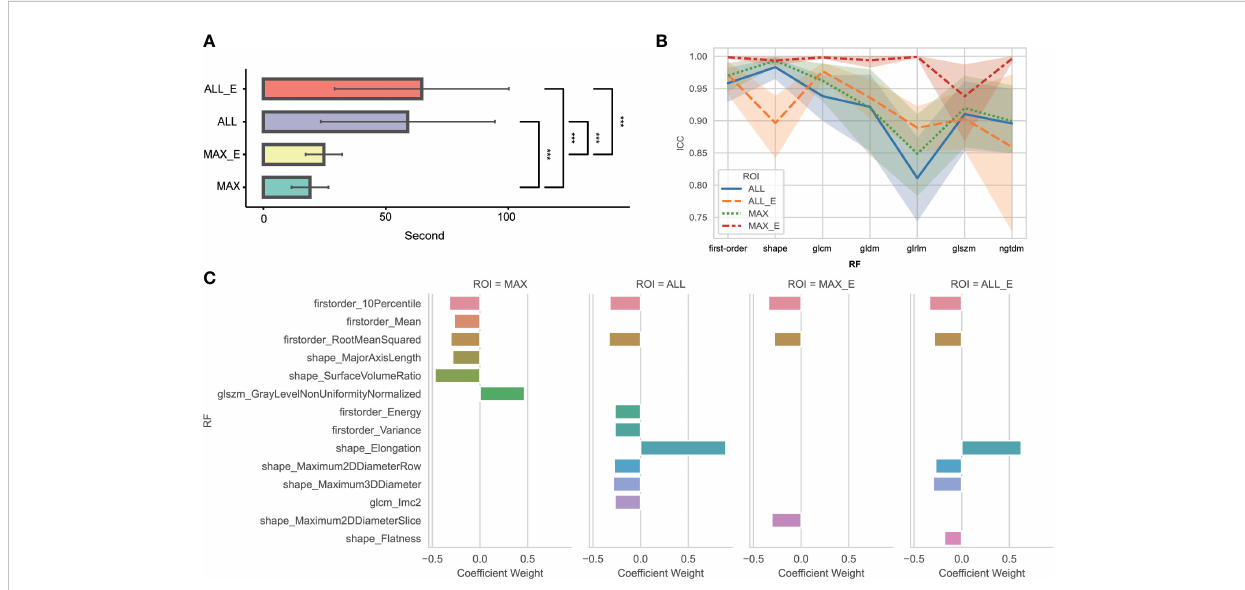
FIGURE 3 (A) Comparative analysis of time consumption between four segmentation methods. *** Indicates P < 0.01. No statistically signi fi cant difference was found between ALL and ALL_E, MAX, and MAX_E. (B) ICC variation amplitude for different segmentation methods and radiomics features in each group. glcm is a gray-level co-occurrence matrix; gldm is a gray-level dependence matrix; glrlm is a gray-level run length matrix; glszm is a gray- level size zone matrix; ngtdm is a neighboring gray-tone difference matrix; and RF is radiomics features. (C) Radiomics features and weights of the four segmentation methods fi nally included in the model. RF is radiomics